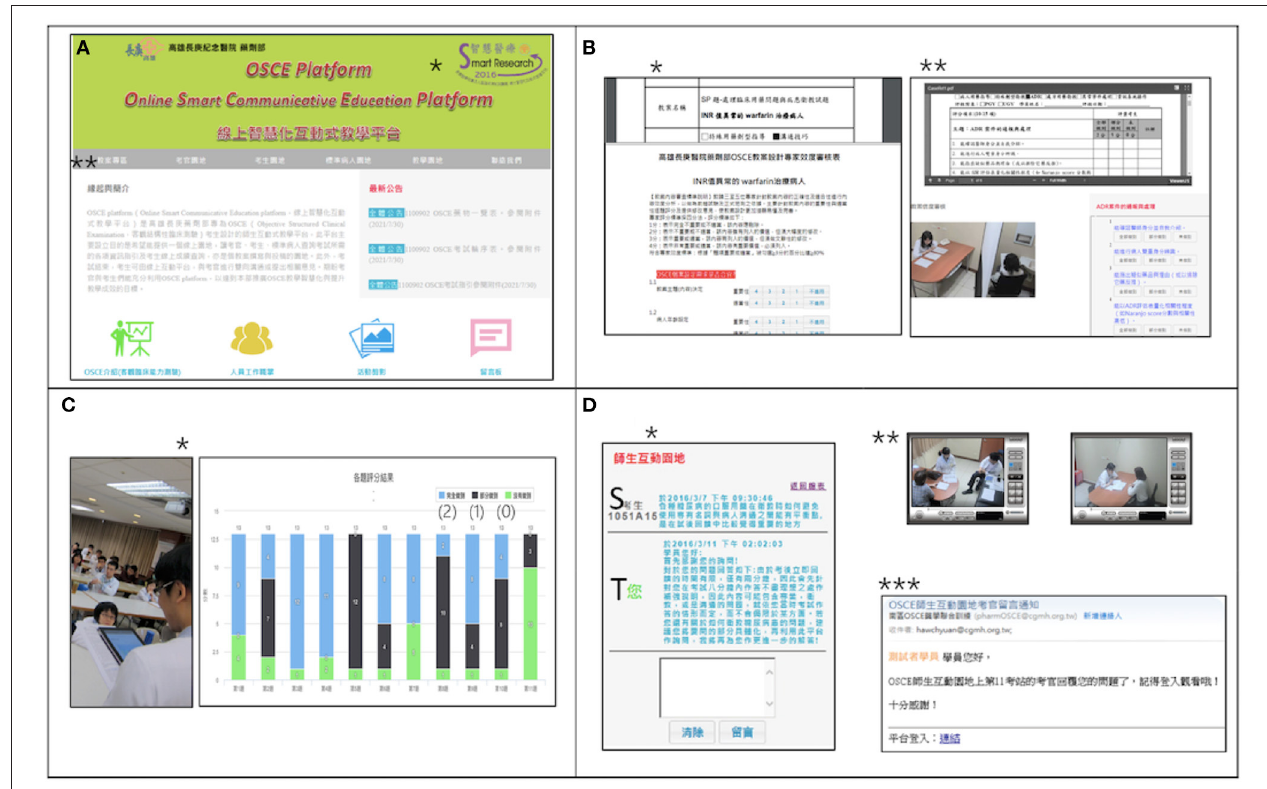
FIGURE 2 | Online Smart Communicative Education System. (A) Homepage of Online Smart Communicative Education System (https://www1.cgmh.org.tw/intr/ intr4/c8g000/OSCE/OSCE_index.asp). *Smart Research Award of Smart Hospital by Joint Commission of Taiwan in 2016; **The icons indicate the entries of “Task-submission,” “Raters,” “Students,” “Standardized patients,” “Online teaching forum,” and “Contact.” (B) Task submission: It provides task-submission, peer-review, online video, and checklist for analysis of validity (*) and reliability (**simultaneous online video with a rating for reliability). (C) Circuit feedback: The program director debriefs common mistakes from automatic plotting and real time calculation by mobile devices (*) instantly; “(2), (1), (0)”: the scale for rating; bars with different colors depict participants’ responses). (D) Extended online feedback: *Students (S) may access to ask more questions after OSCE and teachers (T)